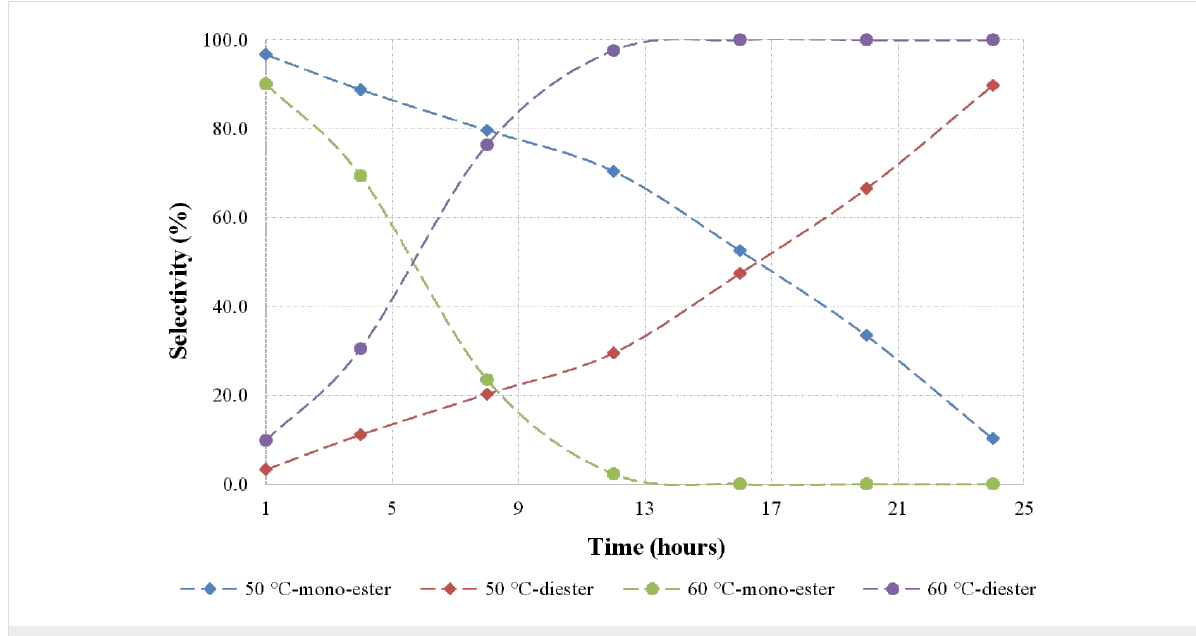
Figure 2: Product distribution as a function of time.